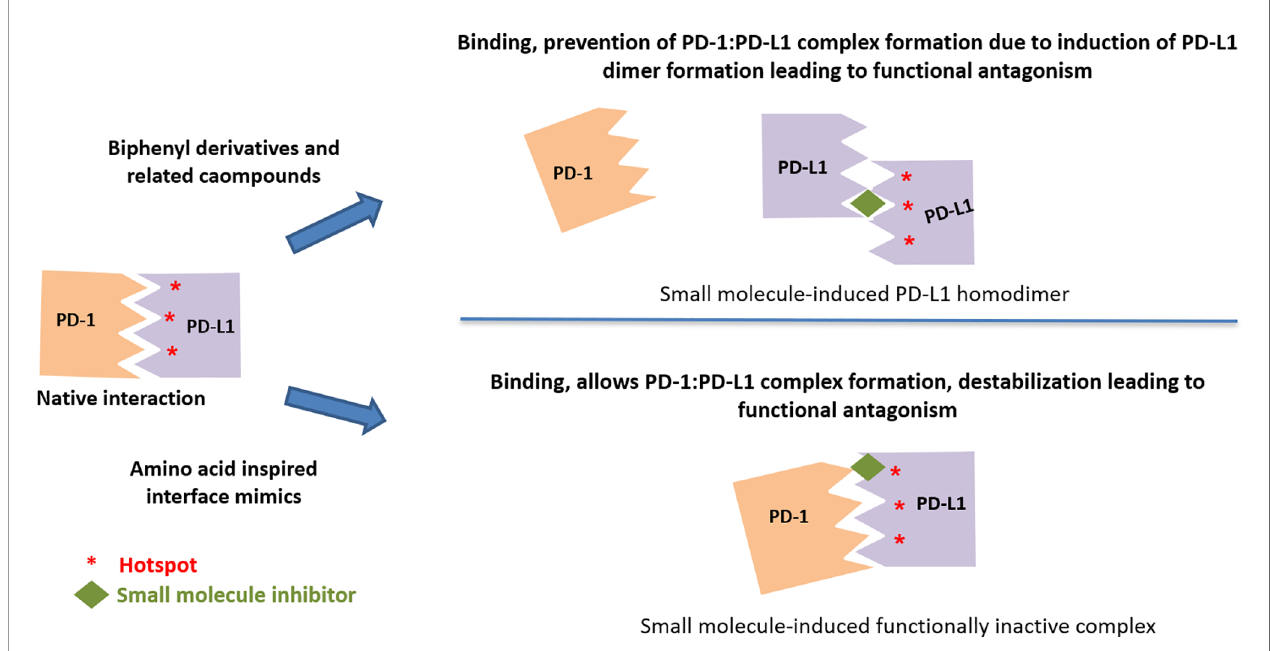
FIGURE 6 | Two distinct mechanisms leading to functional antagonism with reported small molecule PD-L1